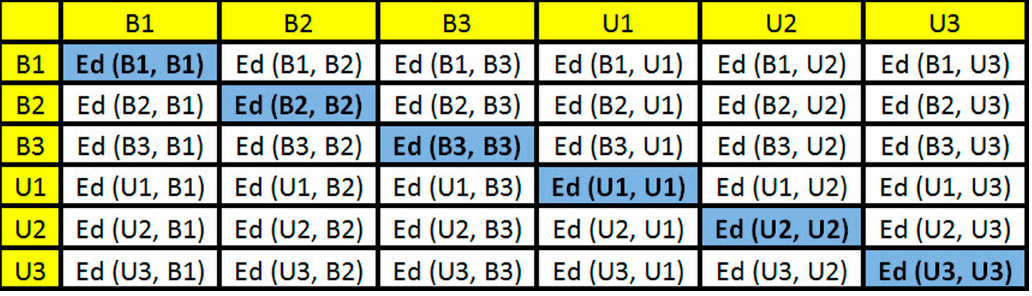
Figure 7. ED-matrix formed after computing ED from the EMI signatures.